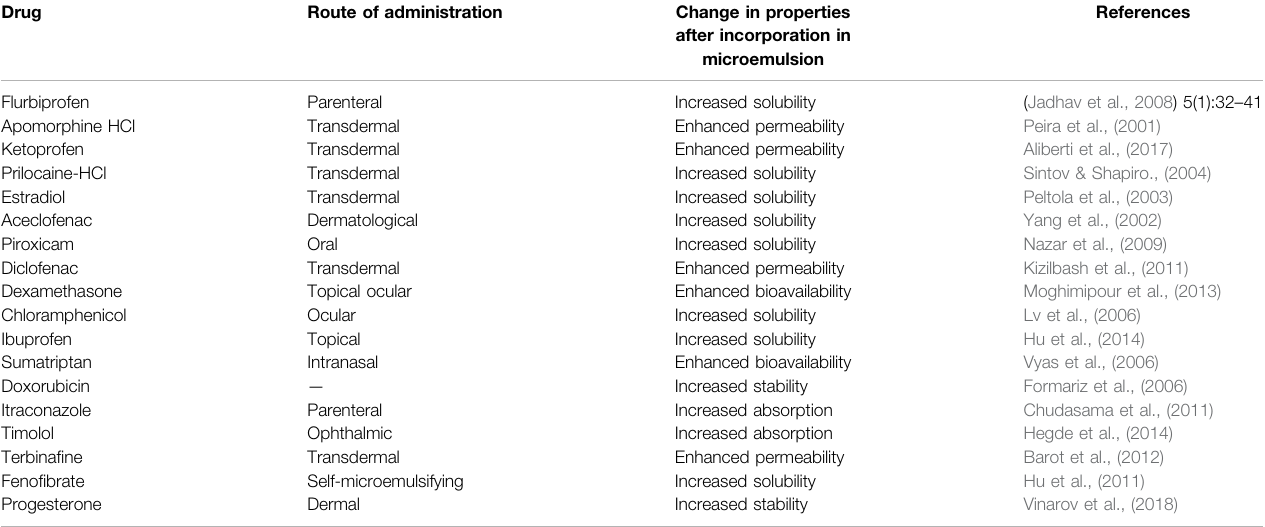
TABLE 2 | Recent research work on poorly soluble